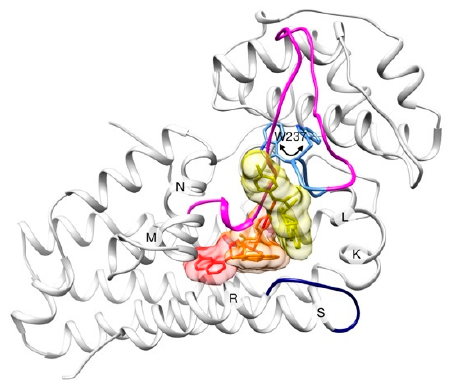
Figure 3. Schematic representation of the binding process of BMS to hIDO1. The three consecutive positions of the inhibitor are shown in yellow (step 1), orange (step 2) and red (step 3). Only one enzyme conformation (at step 3) is shown for clarity. LM-loop is colored in magenta (with its so-called “hairpin” in blue), and RS-loop is colored in dark blue. Rotation of W237 which produces the un/refolding of LM-loop hairpin is highlighted in sticks